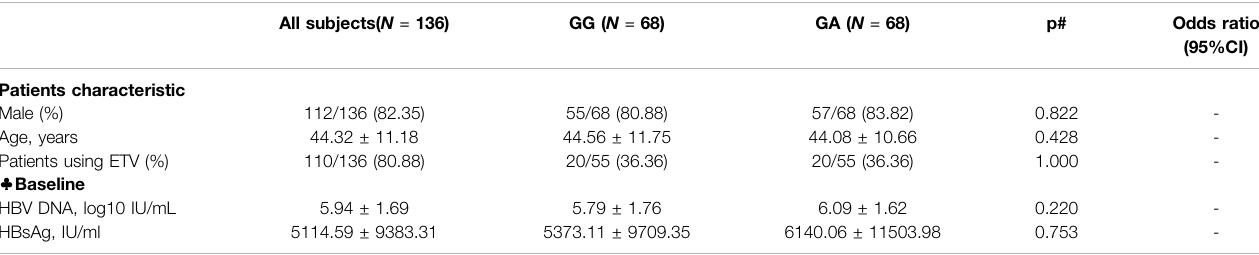
TABLE 1 | Compared characteristics of wild-type control and heterozygote